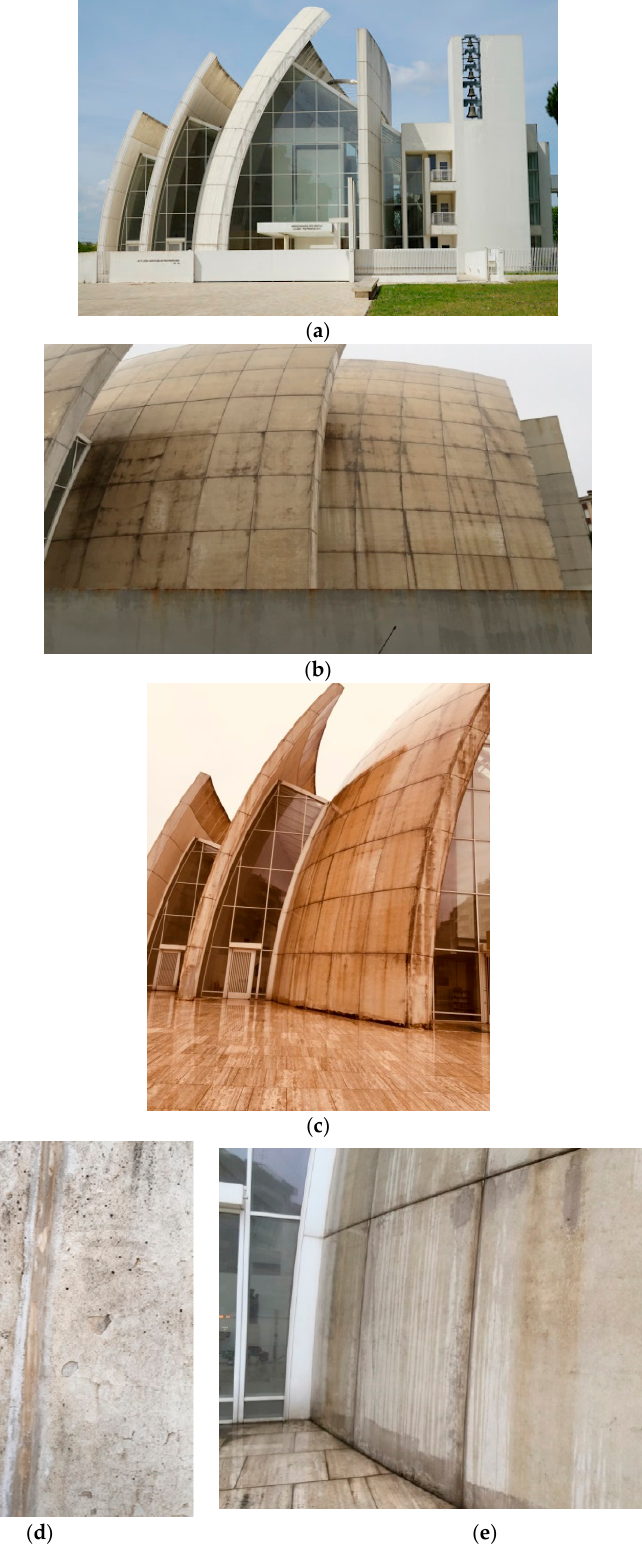
Figure 48. ( a ) Google Earth photograph of the Dives in Misericordia Church in Rome, Italy (unloaded Spring of 2017); and ( b – e ) photographs of the Dives in Misericordia Church taken on 24 February 2018 (Copyright by N. Serpone). Note the breaking-up of the cementitious layer on the outside sails.